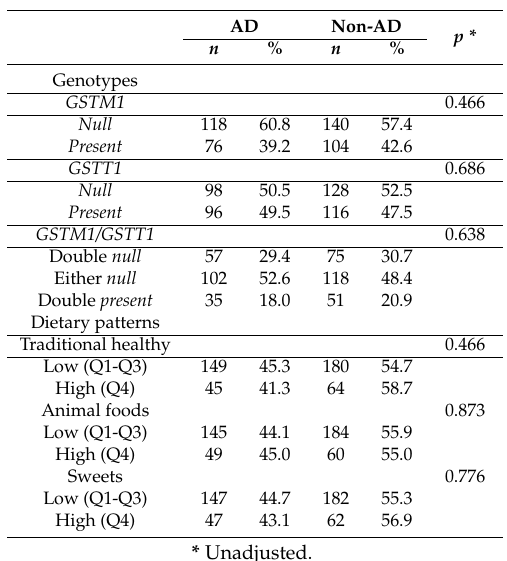
Table 5. Associations of the glutathione S-transferase M1 ( GSTM1 ) and T1 ( GSTT1 ) genotypes and dietary patterns with atopic dermatitis (AD).